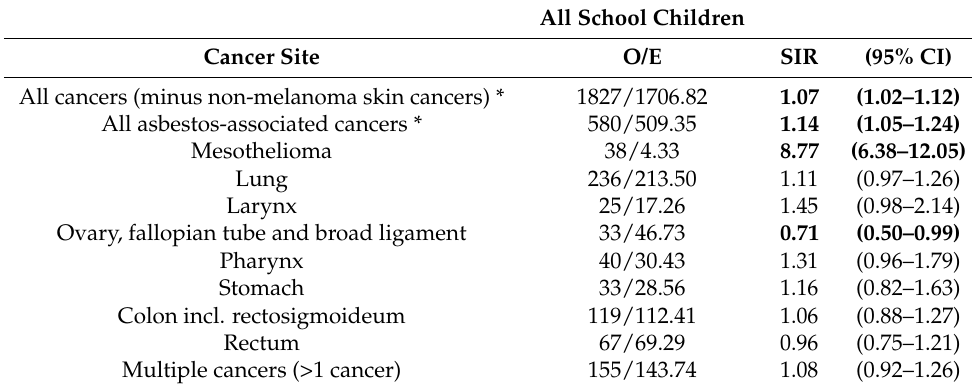
Table 2. Standardized incidence ratios for cancer (1968–2015) among 12111 former school children from